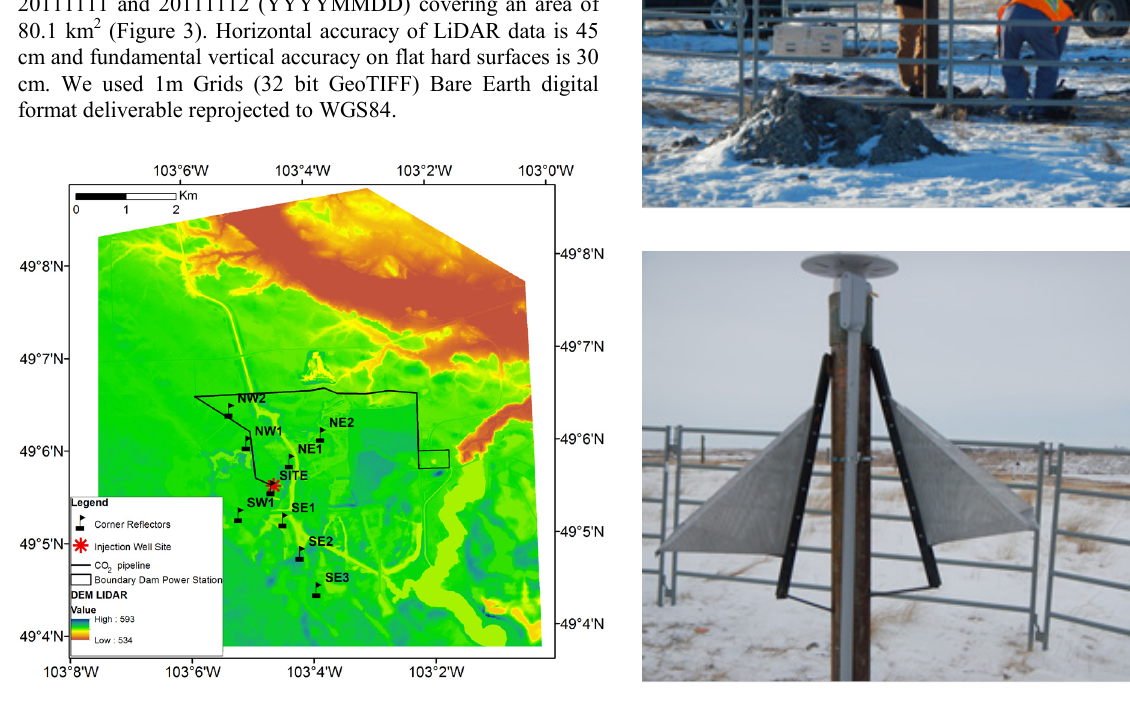
Figure 4. (On the left photo) Instalation works of corner reflectors, (on the right photo) corner reflector suitable for ascending and descening imaging with GPS